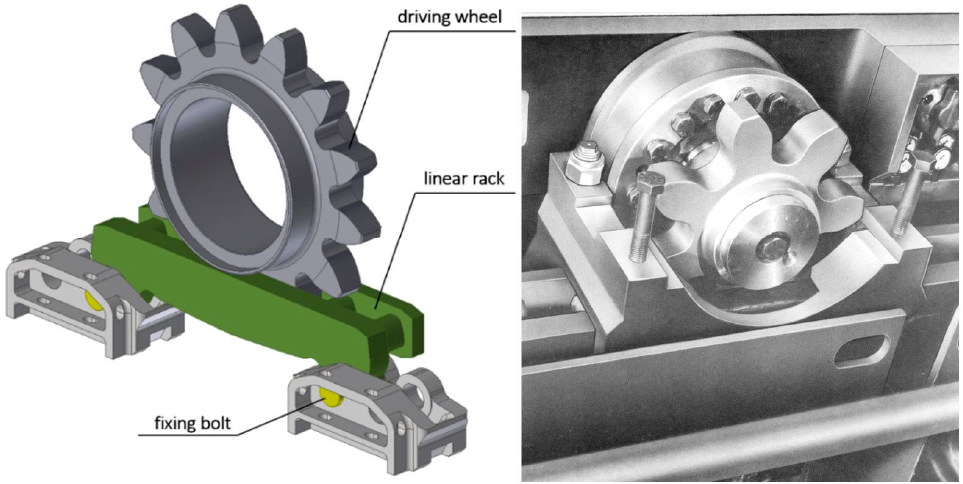
Figure 1. Model and view of the Eicotrack haulage system solution [18].